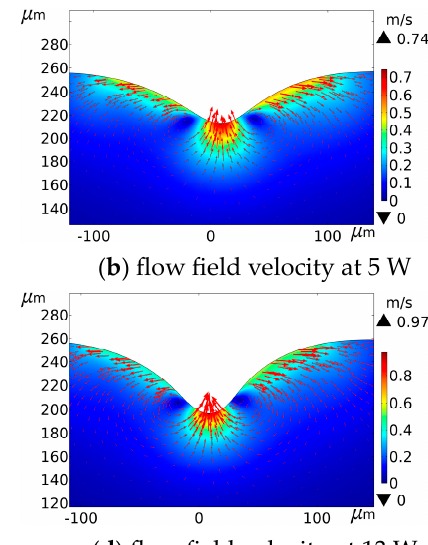
di ff erent scanning speeds.